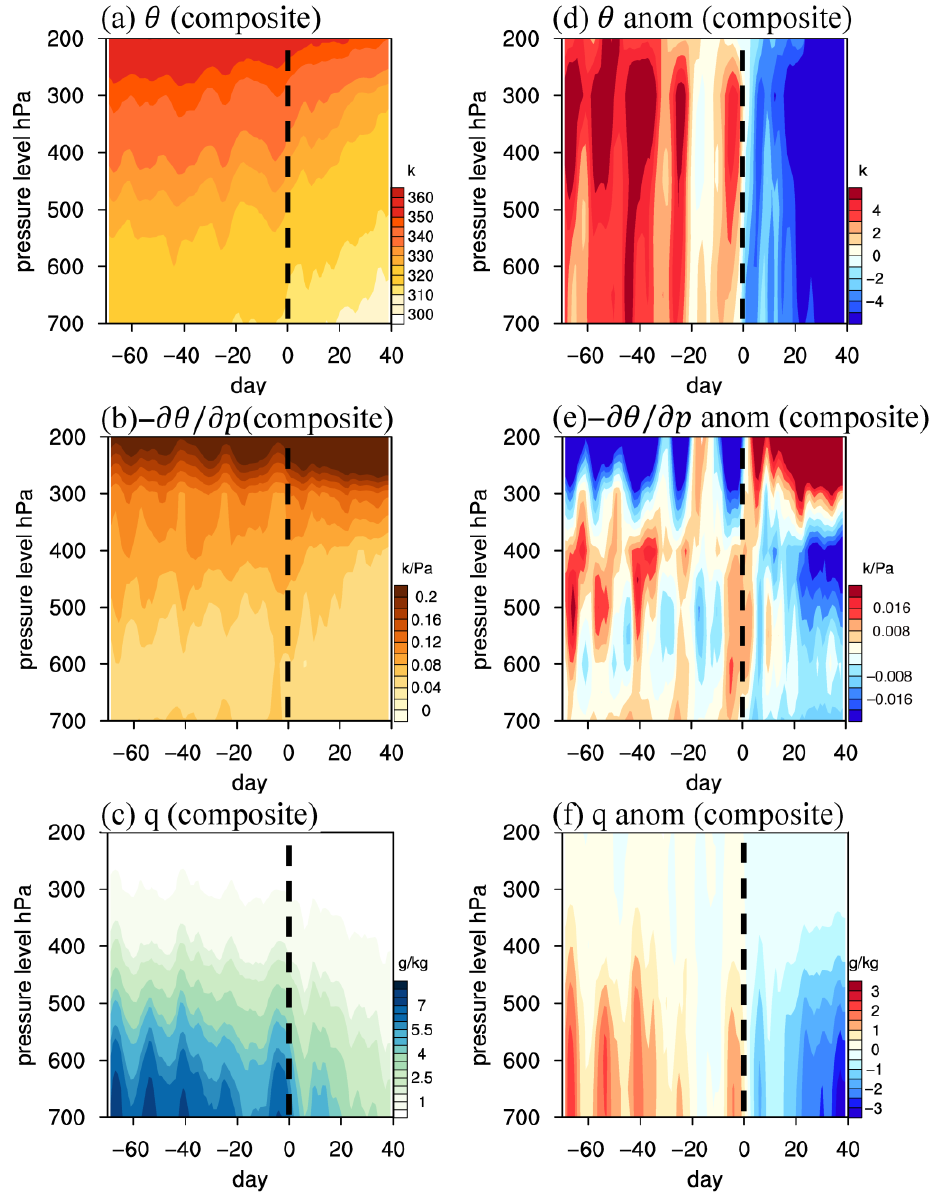
Figure 3. Daily composite analyses for June–October (2010–2015) from day − 70 to 40 relative to transition date averaged over the domain (white box in Figure 1a) for ( a ) average potential temperature (K) and ( b ) potential temperature anomalies (K), ( c ) average static stability (– ∂θ / ∂ p , K / pa) and ( d ) static stability anomalies (K / pa), ( e ) average specific humidity (g / kg), and ( f ) specific humidity anomalies (g / kg) at pressure levels. A 3-day running mean was conducted for all panels, and black dashed lines indicate composite transition